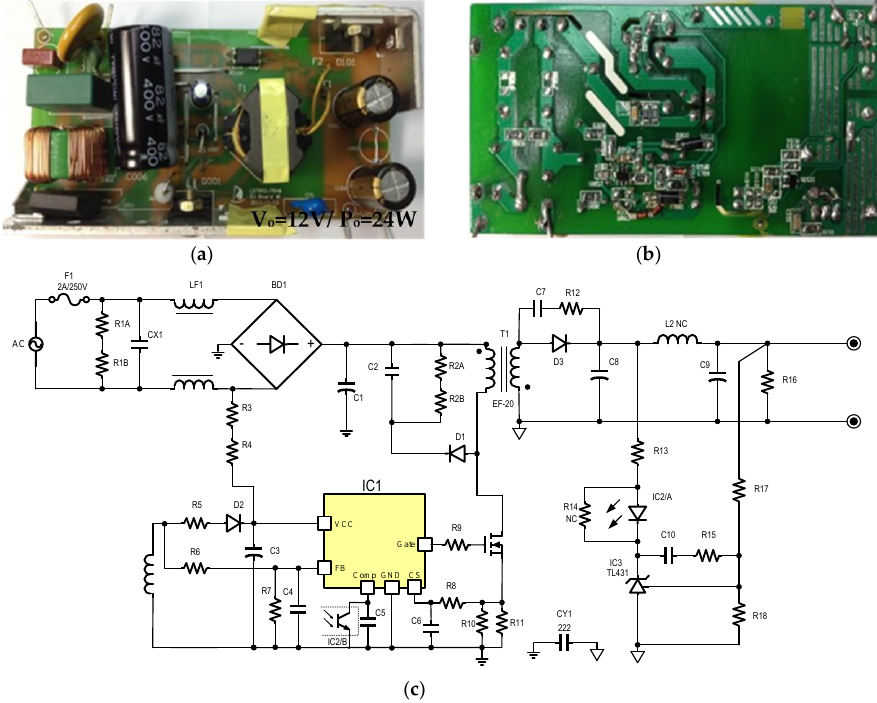
Figure 15. A photograph of the prototypical converter: ( a ) top layer; ( b ) bottom layer; and ( c ) detailed schematic of QRF.